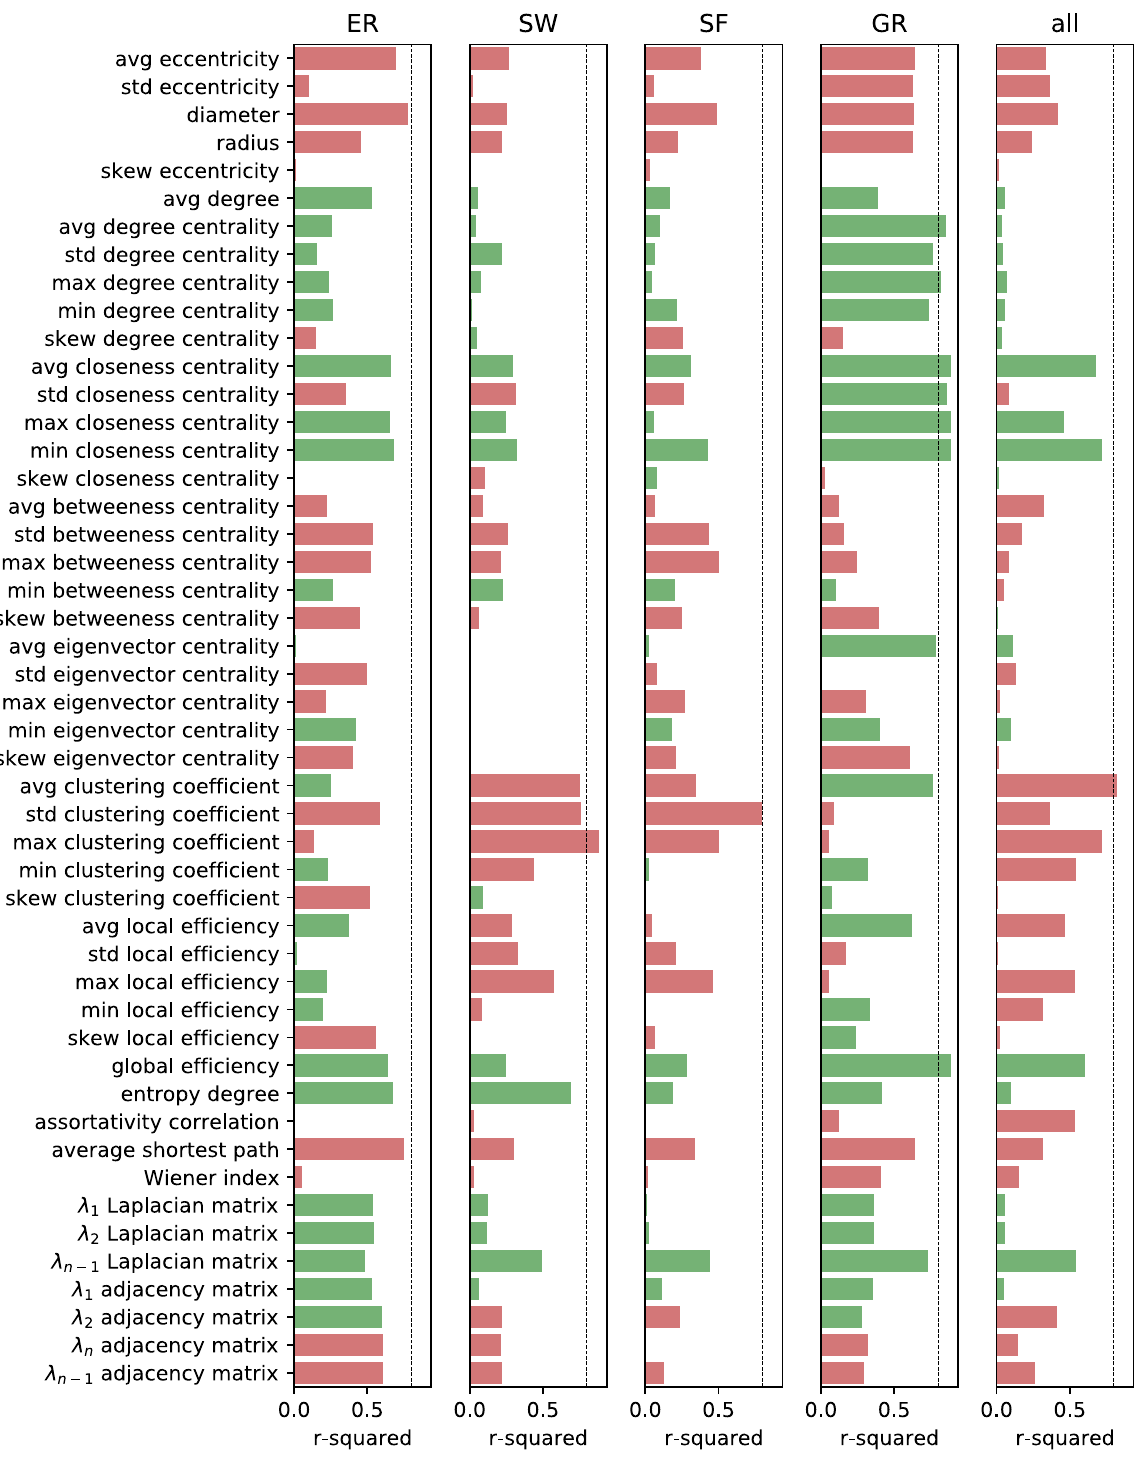
Figure 9. Linear regression r-squared values of graph metrics versus convergence rate for each graph family and for all graphs, coloured in red if the regression coefficient is negative and green if positive. The dotted line indicates an r-squared value of